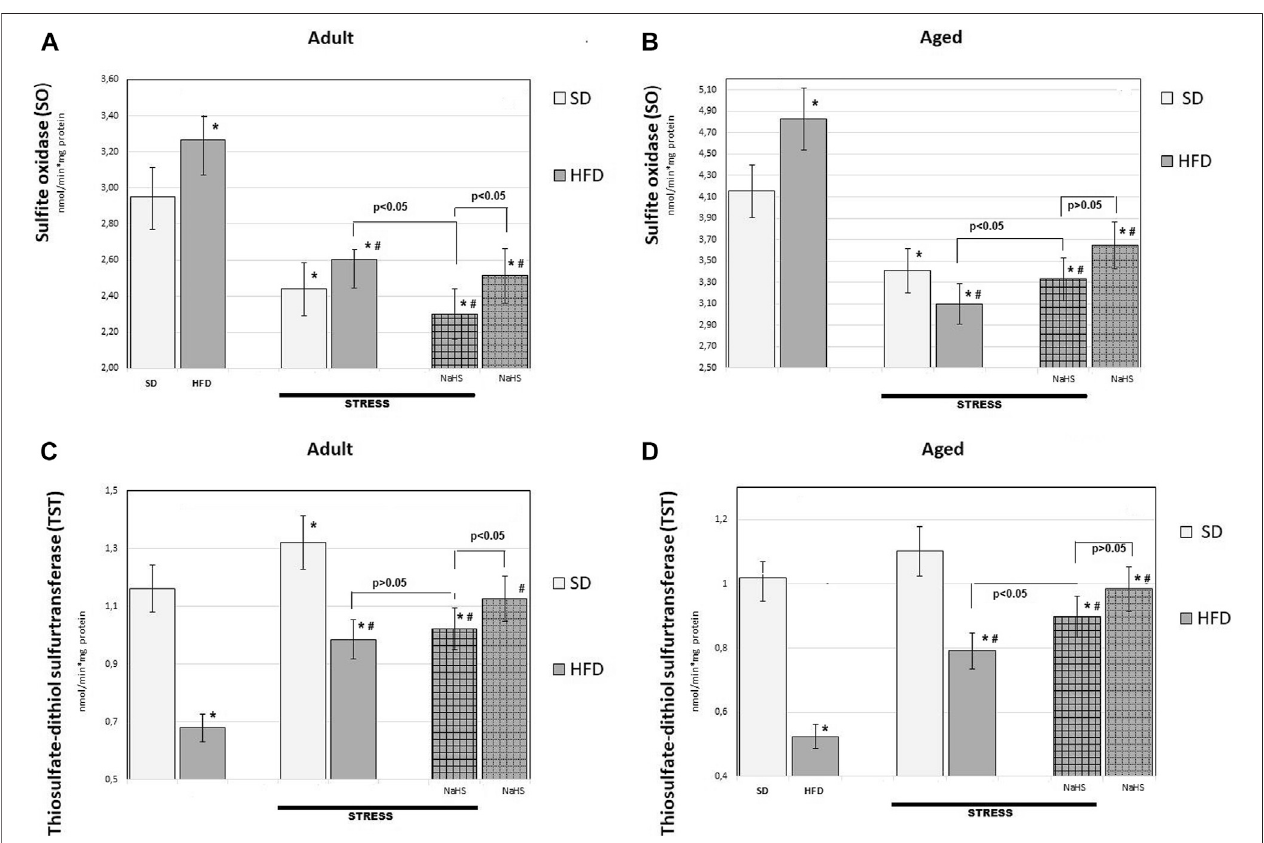
FIGURE 7 | Activities of sul fi de oxidase (A,B) and thiosulfate-dithiol sulfurtransferase (TST) (C,D) in adult (A,C) and aged rats (B,D) ( n (cid:1) 6) fed with a standard diet (SD) or high fructose diet (HFD) without and with H 2 S releasing molecule compound therapy (NaHS) and induction of acute stress; * p < 0.05 vs. SD; # p < 0.05 vs. HFD.